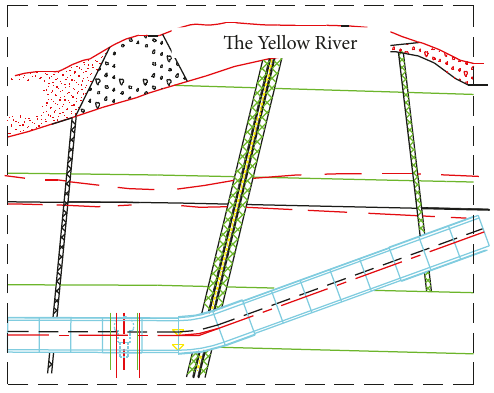
Figure 3: Position sketch of the 3D calculation model.